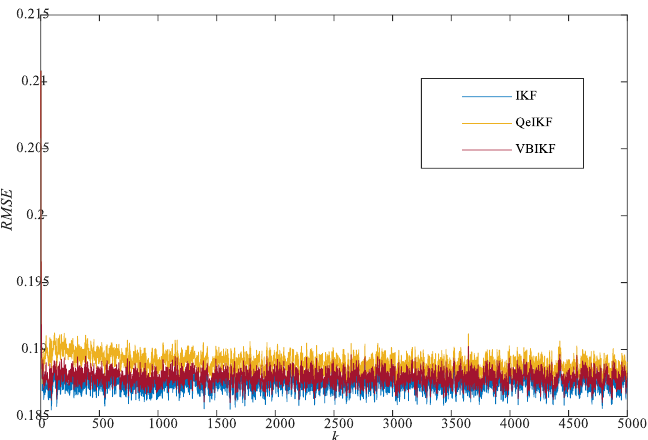
Figure 2. The Figure 2. The RMSE k result of the IKF, the QeIKF, and the VBIKF for the scaled ˆ Σ w with α = 1.